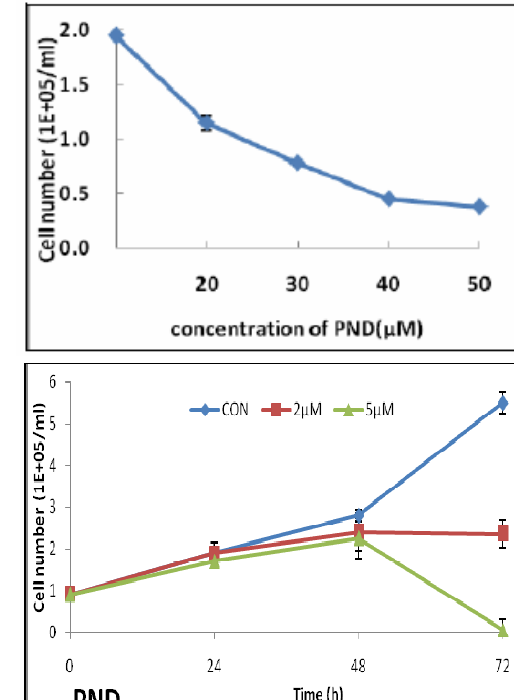
Figure 2. Effects of PNN and PND on the growth of HL60 cells. HL60 cells were incubated with the indicated concentrations of PNN or PND. The growth curve of HL60 cells after treatment with PNN (left) and PND (right) for 24 h ( A ) and 72 h ( B ). Every point represents the mean of triplicate